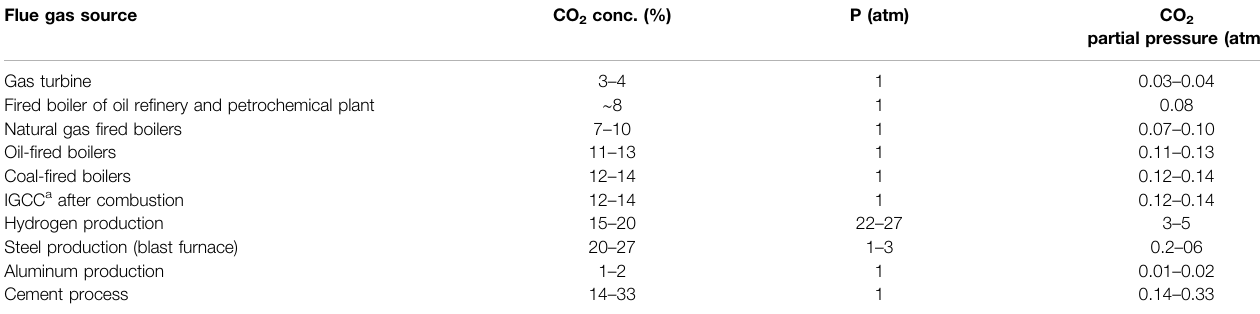
TABLE 2 | Typical CO 2 concentration of a fl ue gas from various sources (Metz et al., 2005; Husebye et al., 2012; Liguori and Wilcox, 2018).